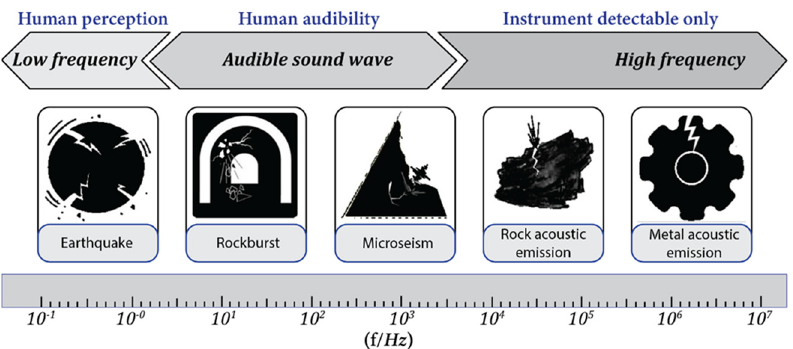
Figure 13. Seismic wave frequency spectrum and application of microseismic techniques ([70]).